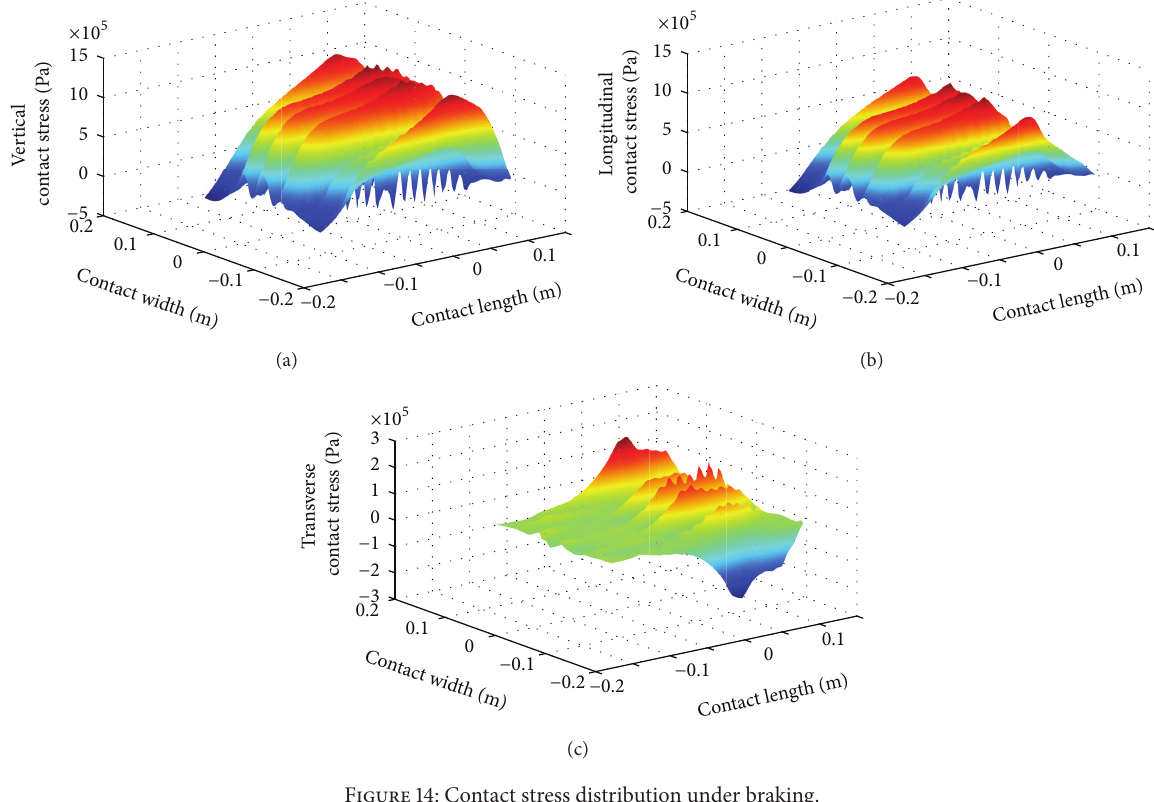
Figure 14: Contact stress distribution under braking.